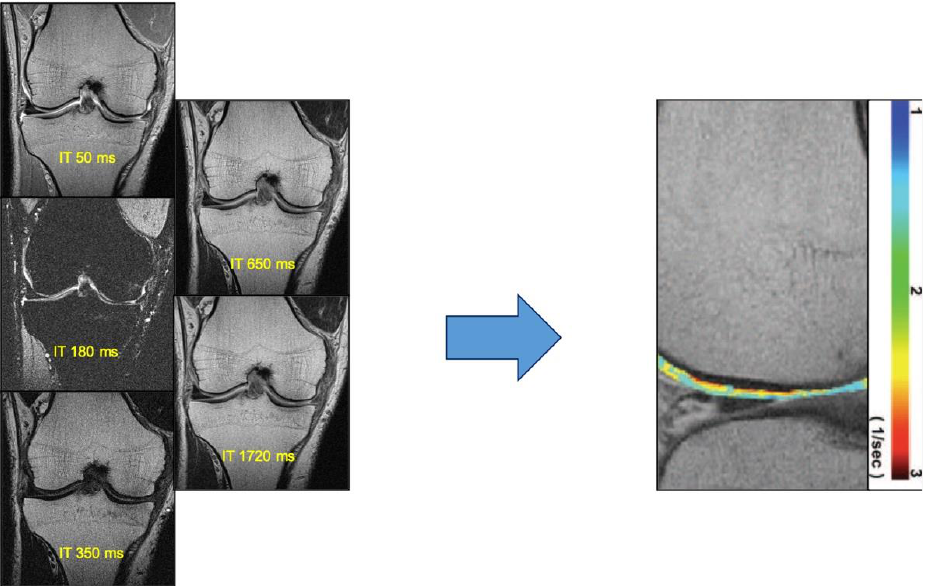
Figure 3. DGEMRIC technique with inversion recovery (IR) images acquired with variable inversion time (IT) and the relative color-coded map of hyaline cartilage.